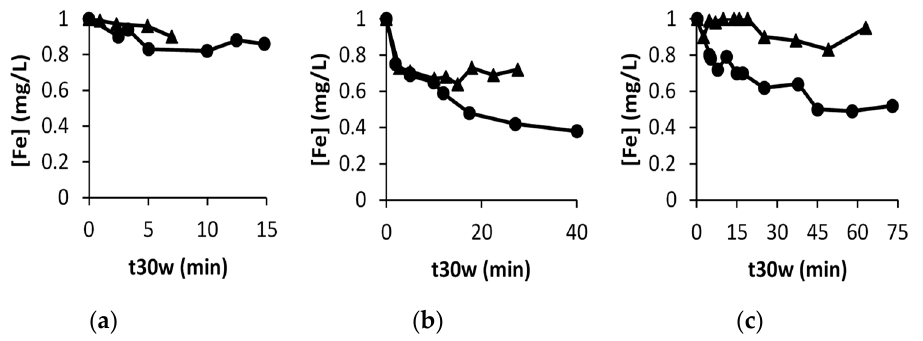
Figure 2. Evolution of Iron concentration in the absence ( ● ) and in the presence ( ) of 5 mg/L of HLS: ( a ) at pH 2.8, ( b ) at pH 5 and ( c ) at pH 7.